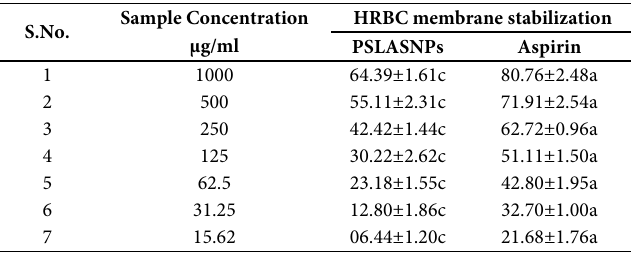
Table2. Anti-inflammatory activity of PSLASNPs sample